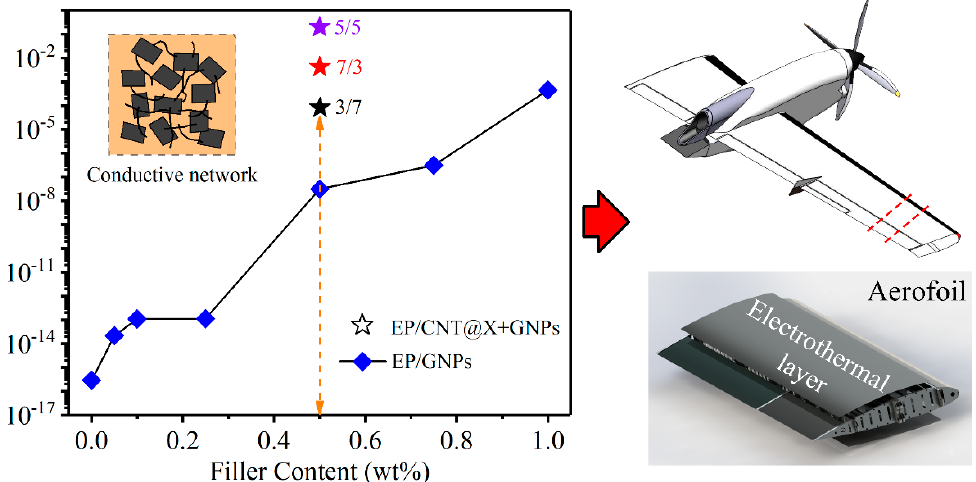
Figure 14. Electrical conductivities of the EP/GNPs and EP/CNT@X+GNPs nanocomposite speci- mens as a function of filler content, and their expected application in the aviation industry.